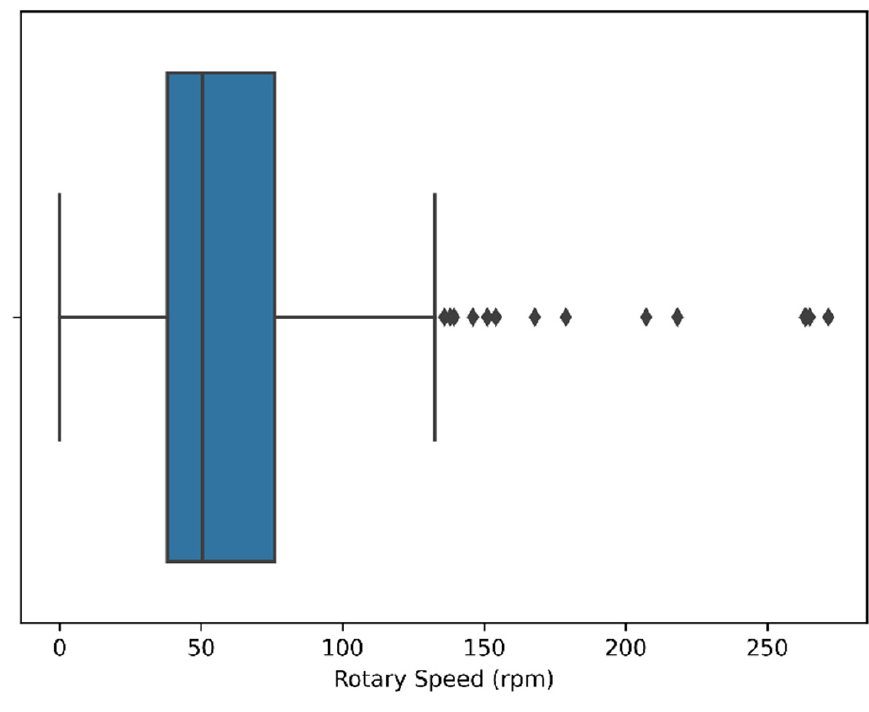
Figure 9. Rotary speed boxplot. Flow in above 7000 (L/min) is considered an outlier (Figure 10).